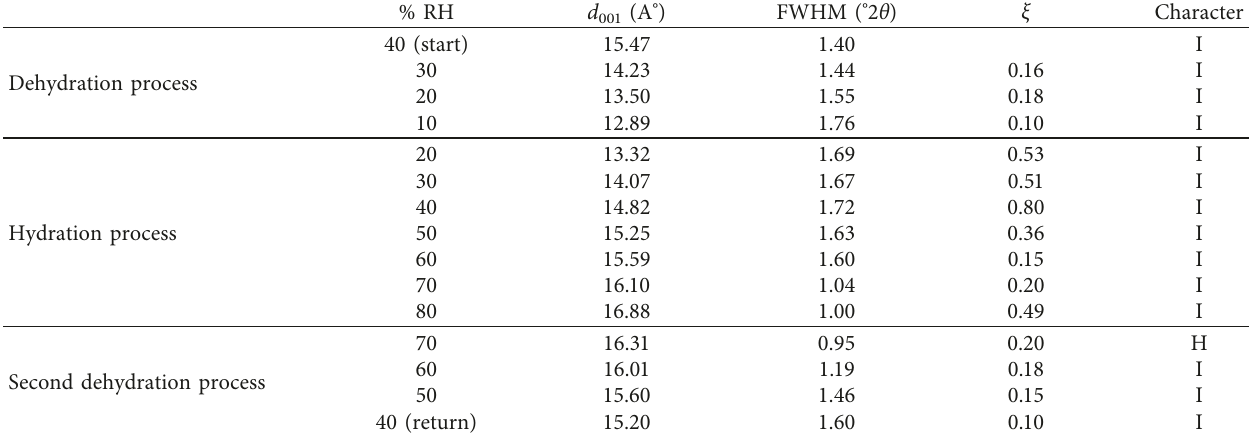
Table 3: Qualitative XRD investigation versus RH% in the case of the second hydration-dehydration